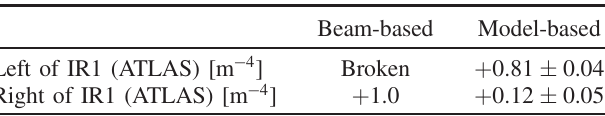
TABLE V. Beam- and model- based correction strength for skew octupole errors in IR1 (ATLAS). Note that the skew octupole corrector right of IR1 is broken and is not considered in the beam-based correction.